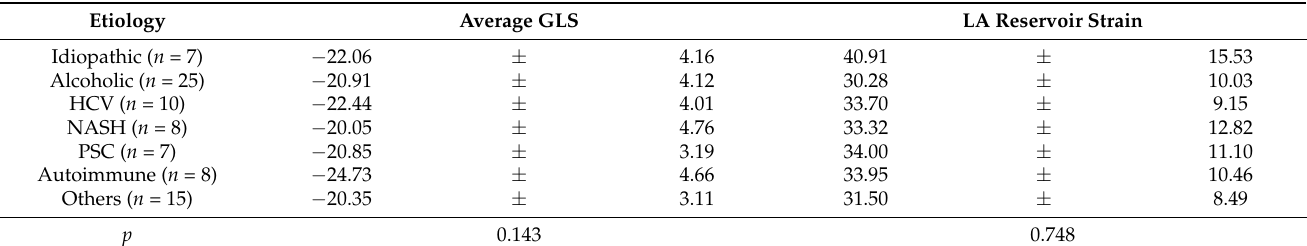
Table 3. Comparison of Global Longitudinal Strain (GLS) and left atrial (LA) reservoir strain for different etiologies of cirrhosis in patients.